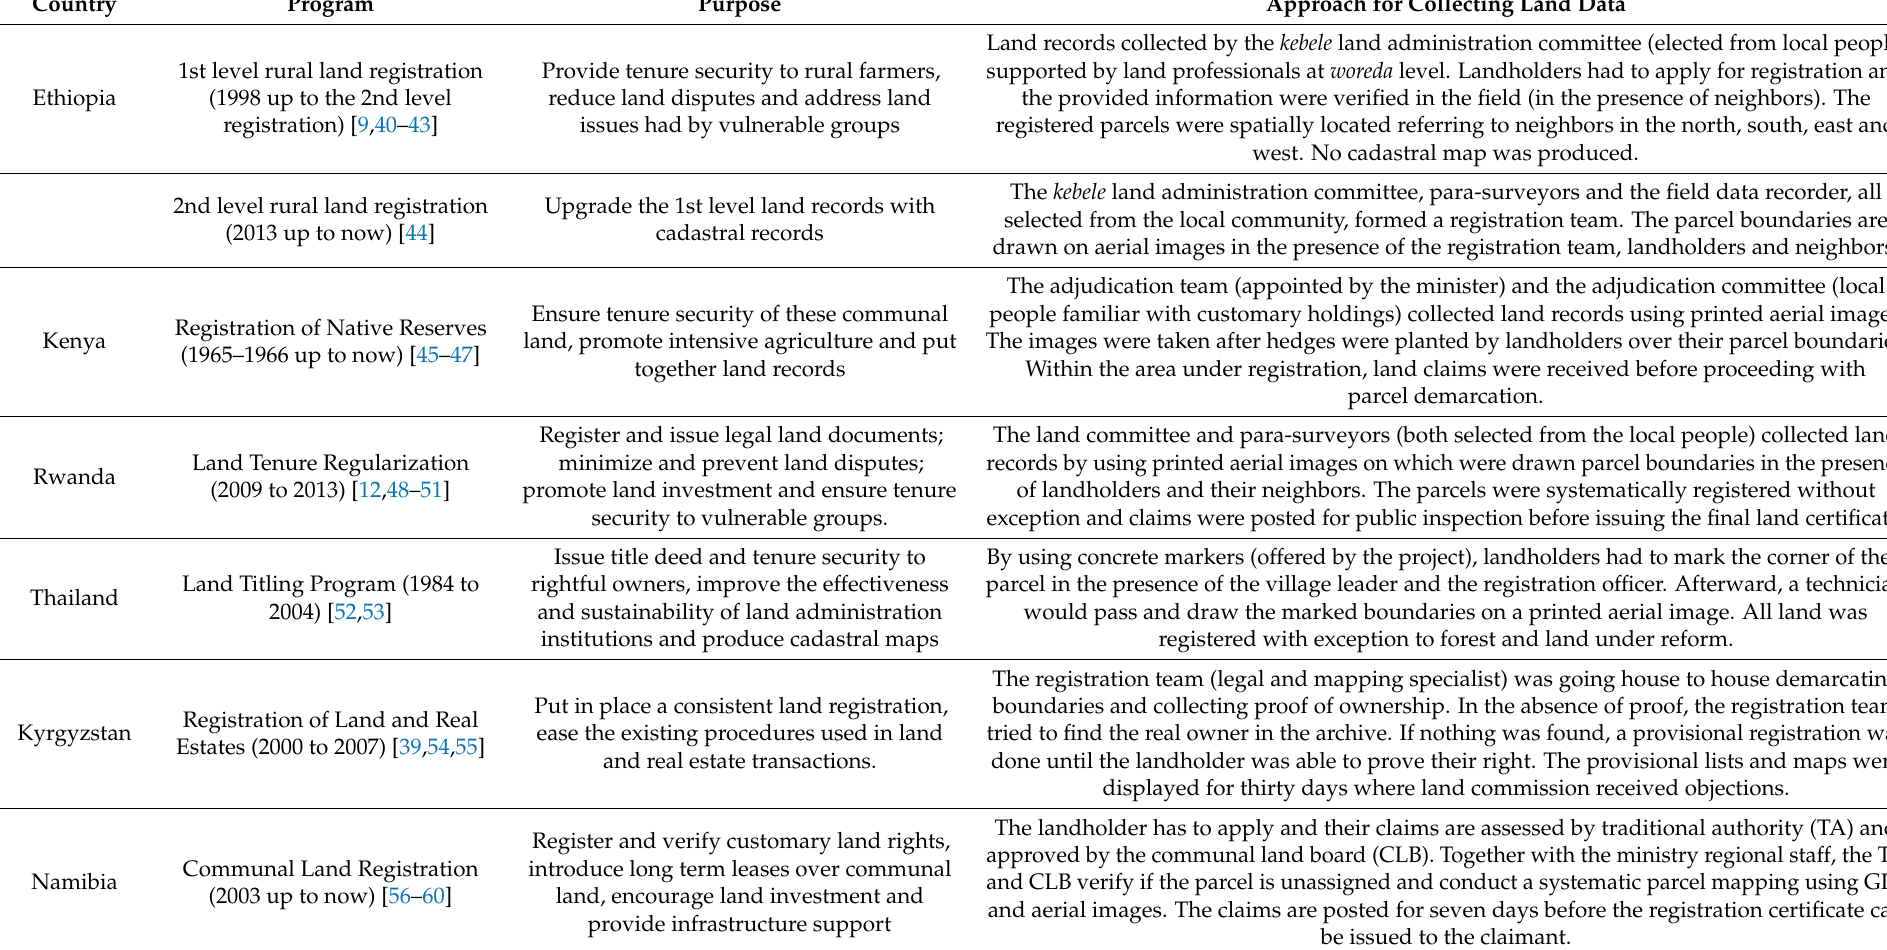
Table 3. Case study countries with their respective land registration